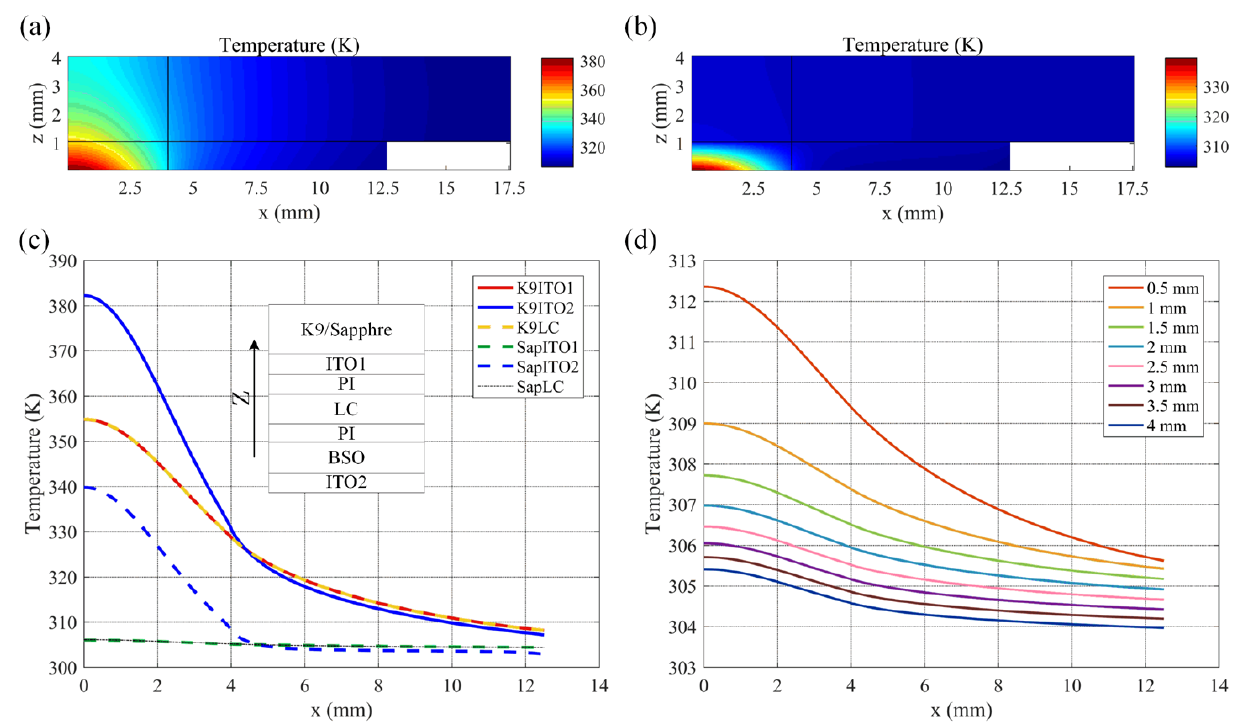
Figure 3. ( a ) Temperature distribution of K9 substrate OASLM. ( b ) Temperature distribution of Sapphire substrate OASLM. ( c ) Temperature curve along the x -axis of each layer structure. The embedded diagram represents the structural position of each floor in the model. ( d ) The influence of sap- phire with different thicknesses on the temperature of liquid crystal layer.